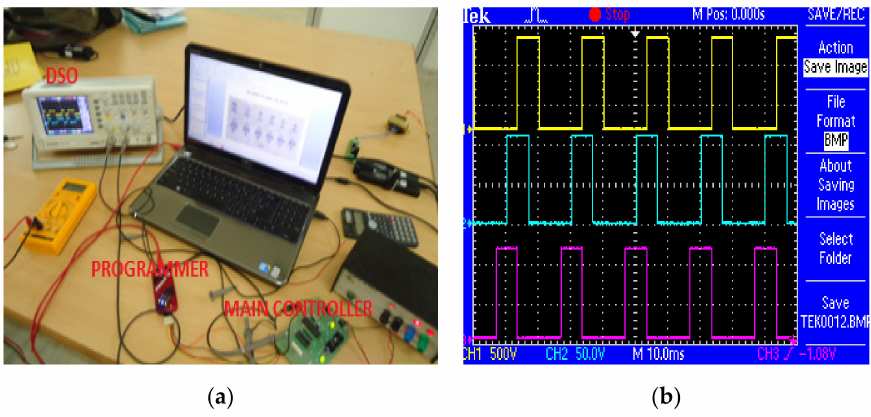
Figure 17. ( a ) Real-time programming environment; ( b ) gate pulse for the three-phase inverter. Similarly, Figure 16b shows the gate pulse of the inverter at different K th intervals of time. Instead of IRF240, low-power MOSFETs are used as driver circuits. The dead time between the outgoing switch and incoming switches are calculated manually and controlled via programming. Finally, Figure 18 deals with the three-phase inverter output, the final output of this proposed system; Figure 18a shows the voltages across a two-phase, no-load condition, and Figure 18b shows the same inverter output with the load condition.